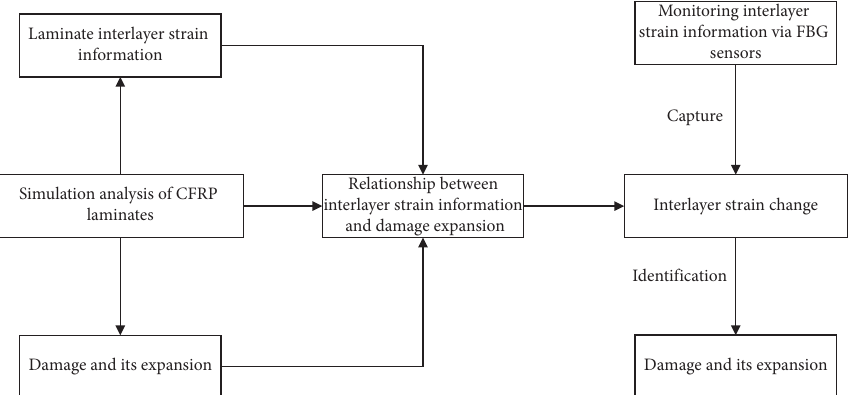
Figure 3: Damage recognition principle of CFRP laminated plates based on FGB sensor.